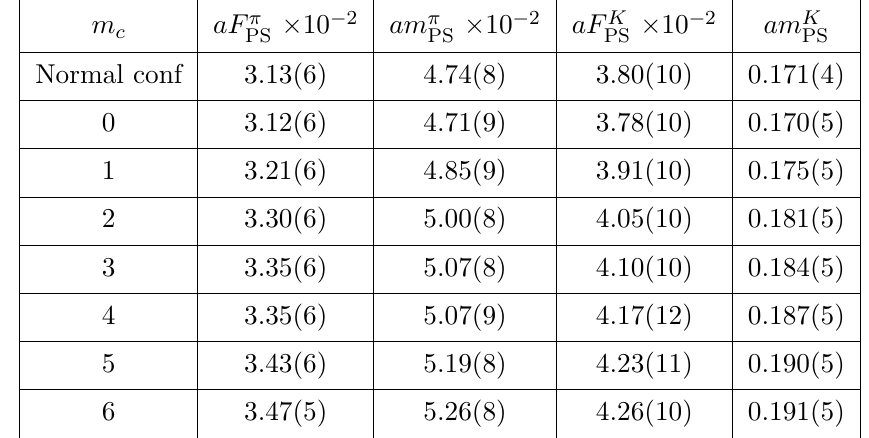
Table 17 . The computed results of the intersections. The superscripts (cid:25) and K indicate the interceptions calculated using equations (6.2) and (6.3),